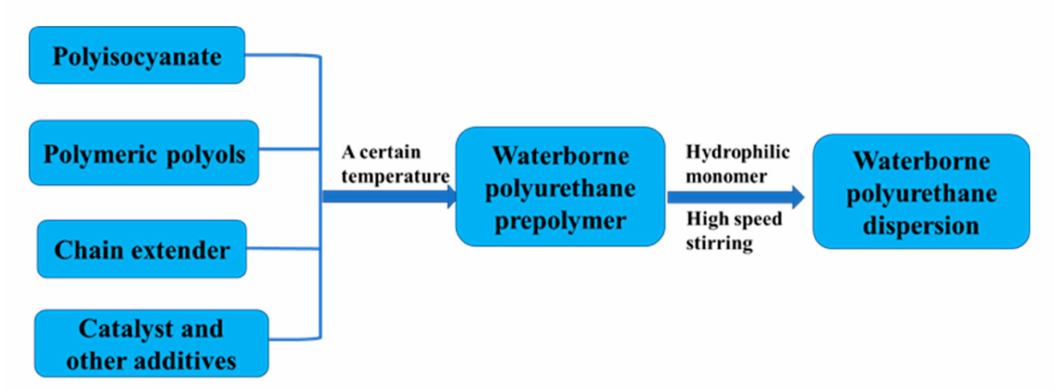
Figure 2. Flow chart of the reaction of polyisocyanate with polyhydroxy compound, polyether and